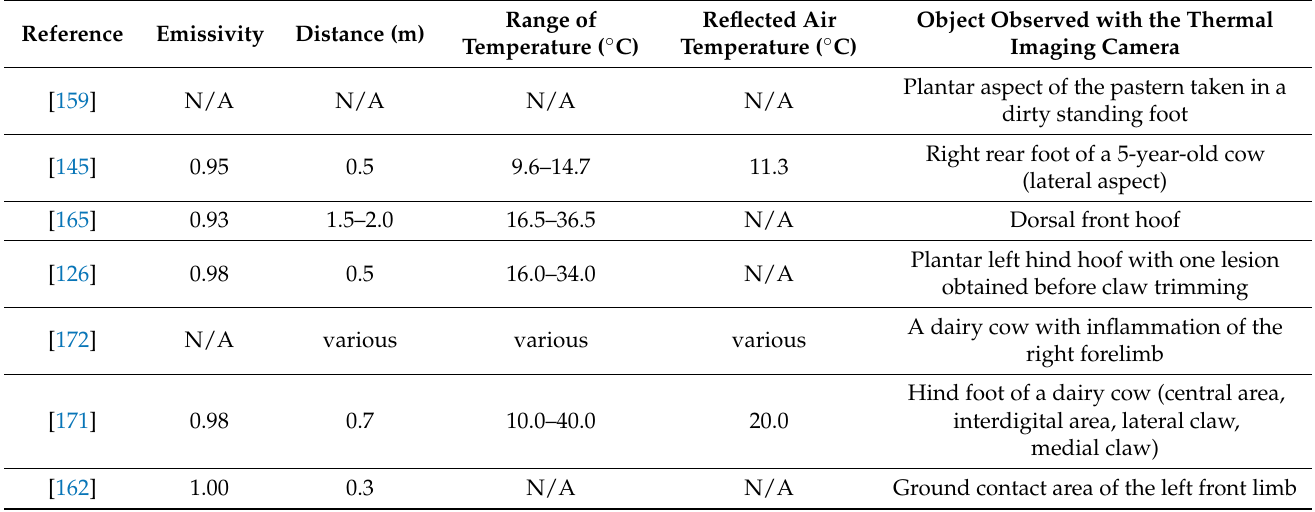
Table 2. Overview of parameters affecting thermographic evaluation in previous